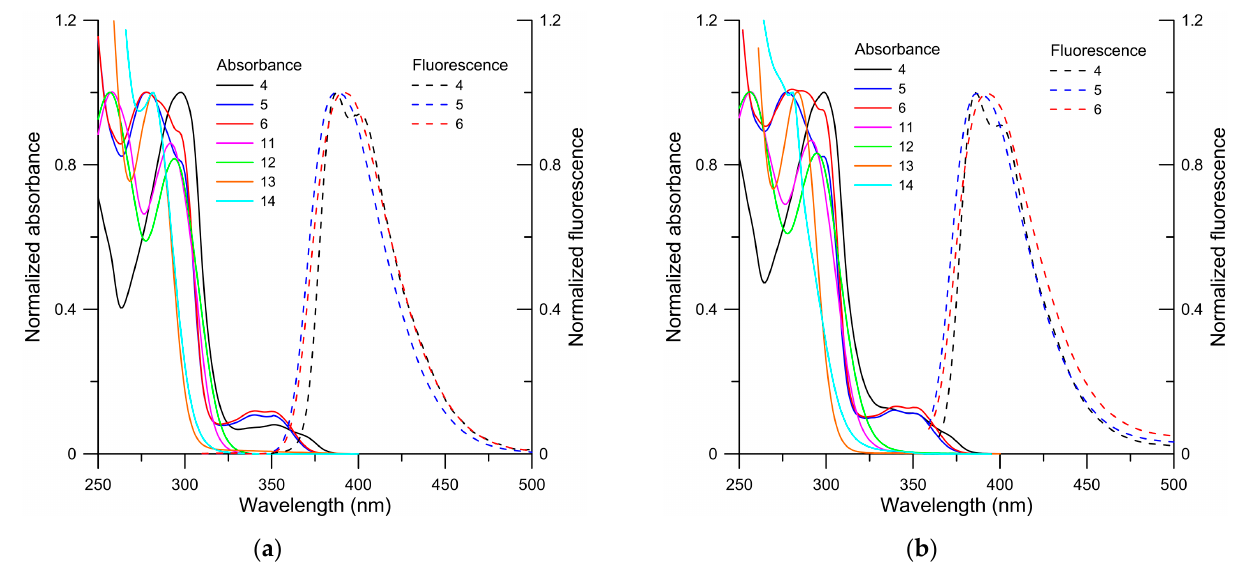
Figure 1. Absorption and emission spectra of studied compounds in: ( a ) acetonitrile; ( b ) dichloromethane. Table 1. Spectroscopic properties of the studied derivatives determined for acetonitrile solutions. Compound